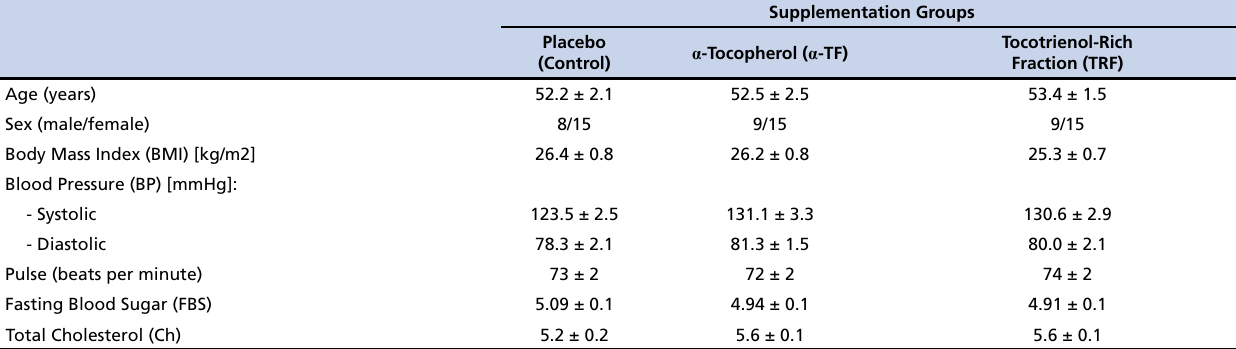
Table 2 - Demographic data of the study